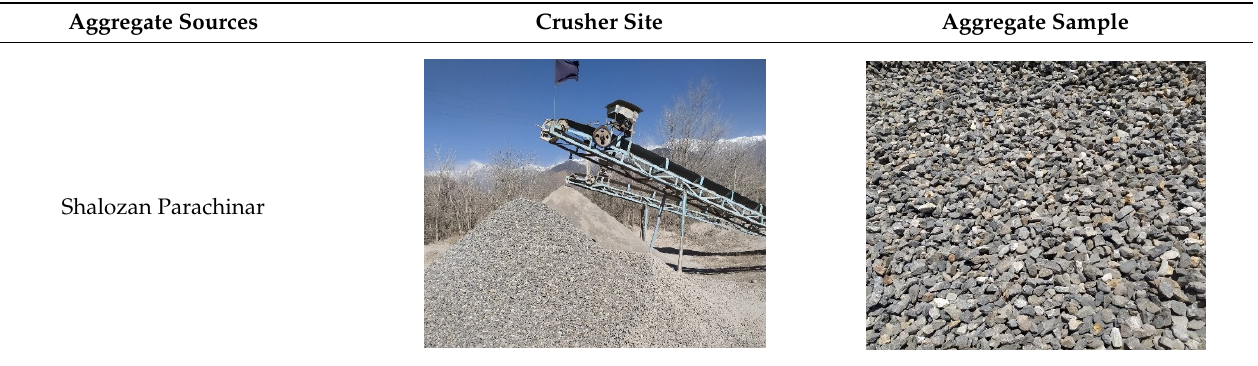
Table 3. Aggregate samples. Table 3. Aggregate